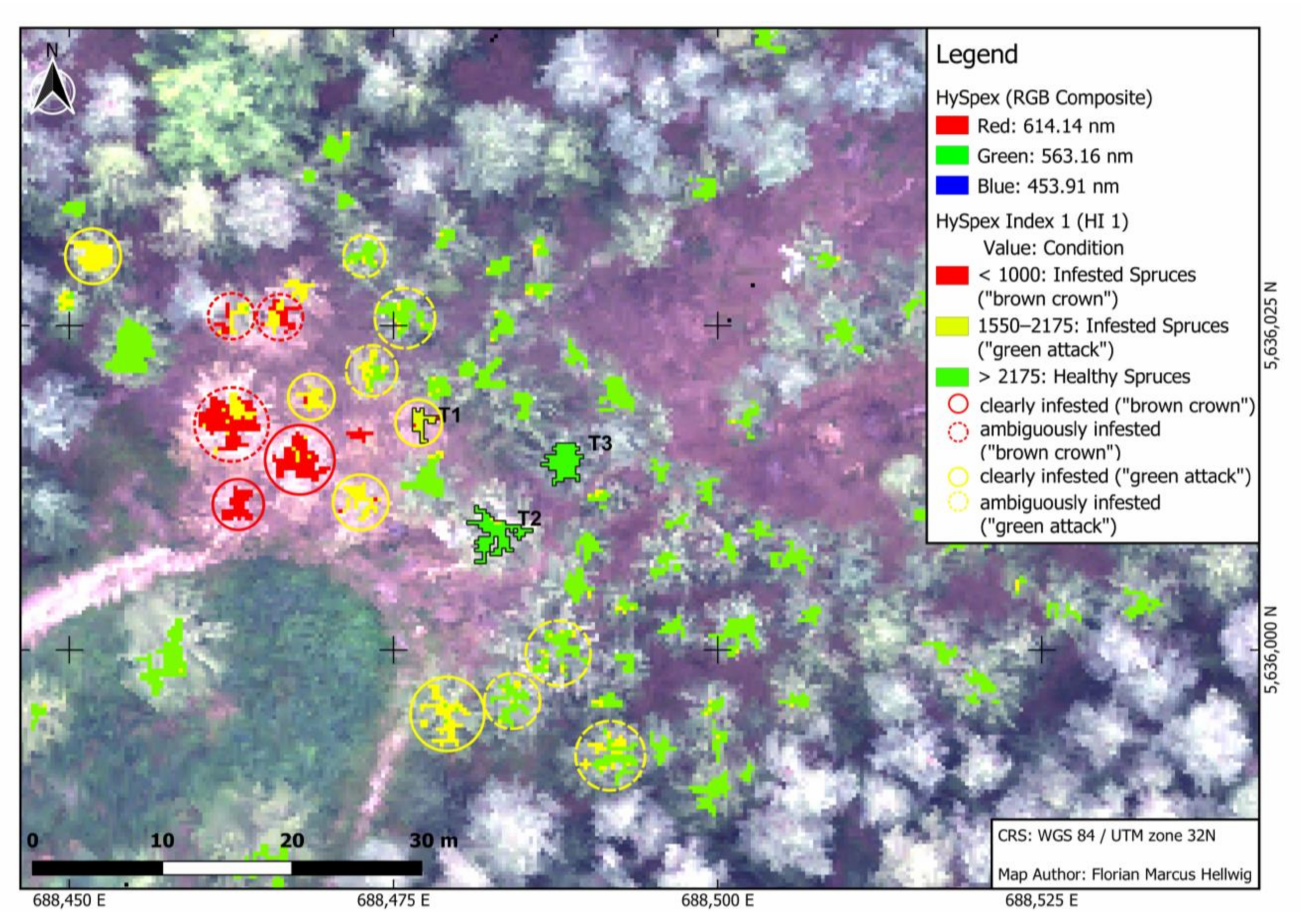
Figure 11. State of the spruces in the first study area using HySpex index 1 (HI 1). A total of 16 spruces were found to be (ambiguously) infested with HI 1. Here, eight spruces belong to the spruces that were not removed, of which two spruces (northwest and south) were clearly classified as infested (green attack) (yellow